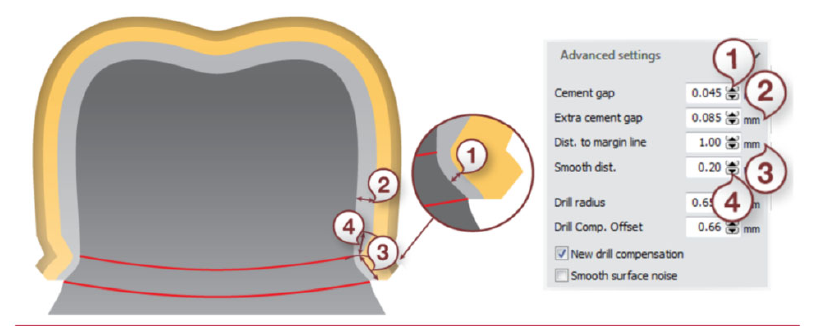
(4) smooth distance (3Shape Dental System 2016 User Manual).